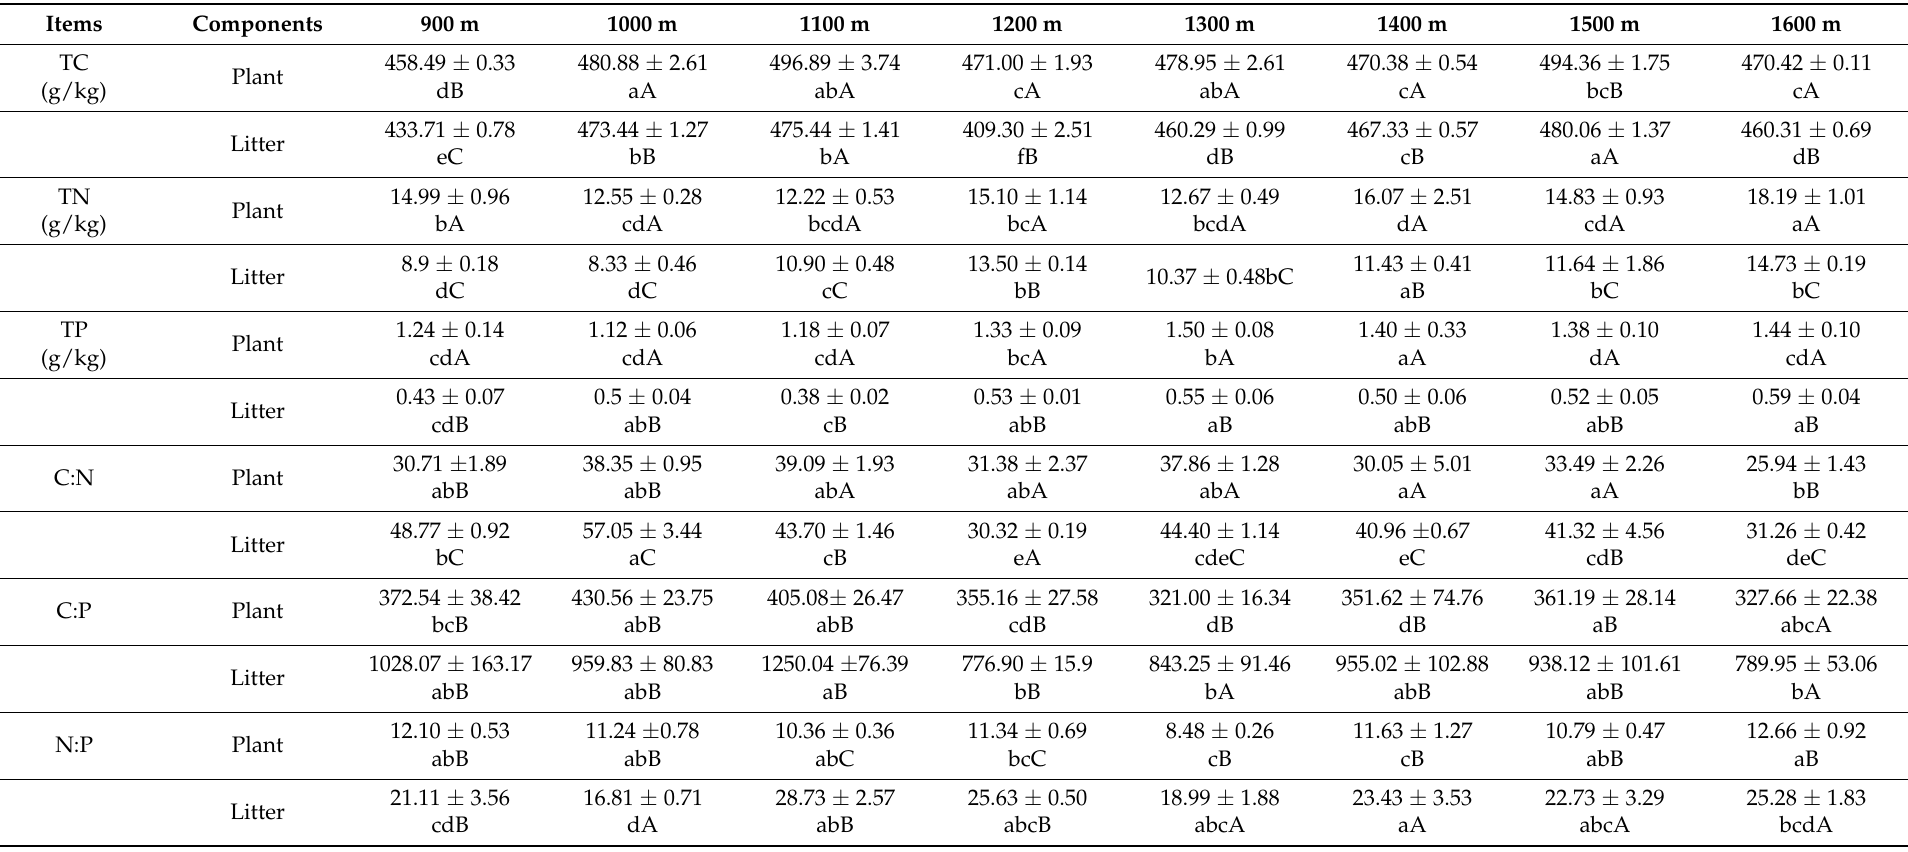
Table 1. C, N and P in plant and litter at different elevations in Daiyun